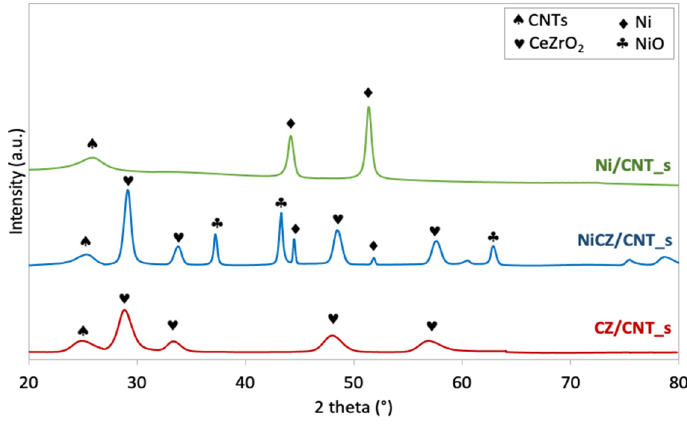
Figure 11. XRD patterns of spent catalysts: CZ/CNT_s, NiCZ/CNT_s and Ni/CNT_s.